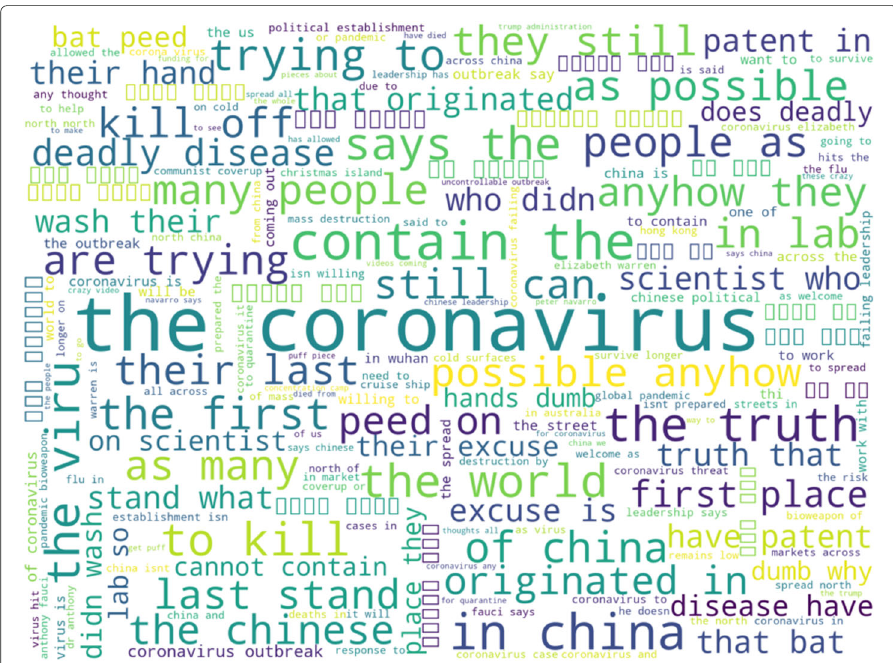
Fig. 14 Word map of commonly occurring phrases and text that co-occur with hashtags from period 1, cluster 6, which is composed of U.S. politics related hashtags. There is a wide range of verbiage employed in the cluster, with much of it focusing on the COVID-19 pandemics origins in China and its subsequent